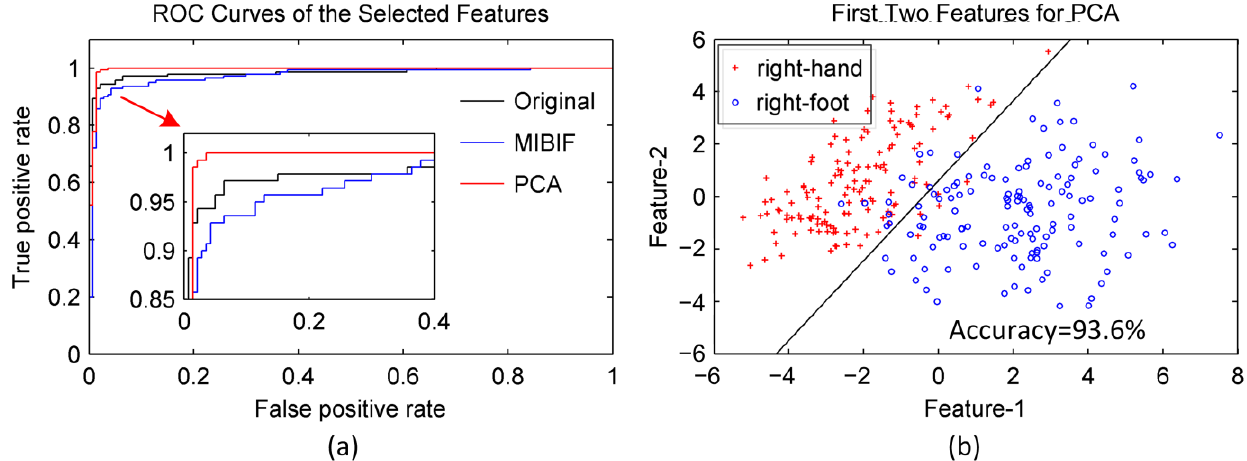
Figure 10. ( a ) The ROC curve of the 57 features selected by MIBIF and 5 features selected by PCA for subjects aa. ( b ) The distribution of the first two features obtained by PCA for subject aa. Note that the right-hand (blue, circle) and right-foot (red, cross) imagery classes are nearly linearly separable with only 2 features.